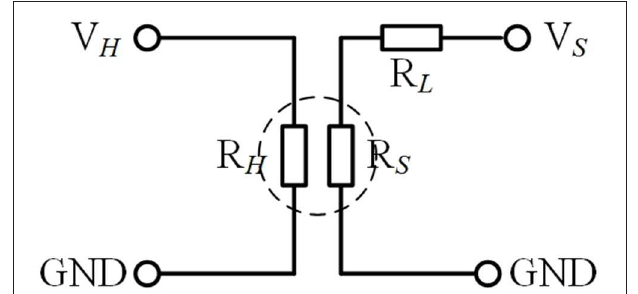
FIGURE 5 | The test